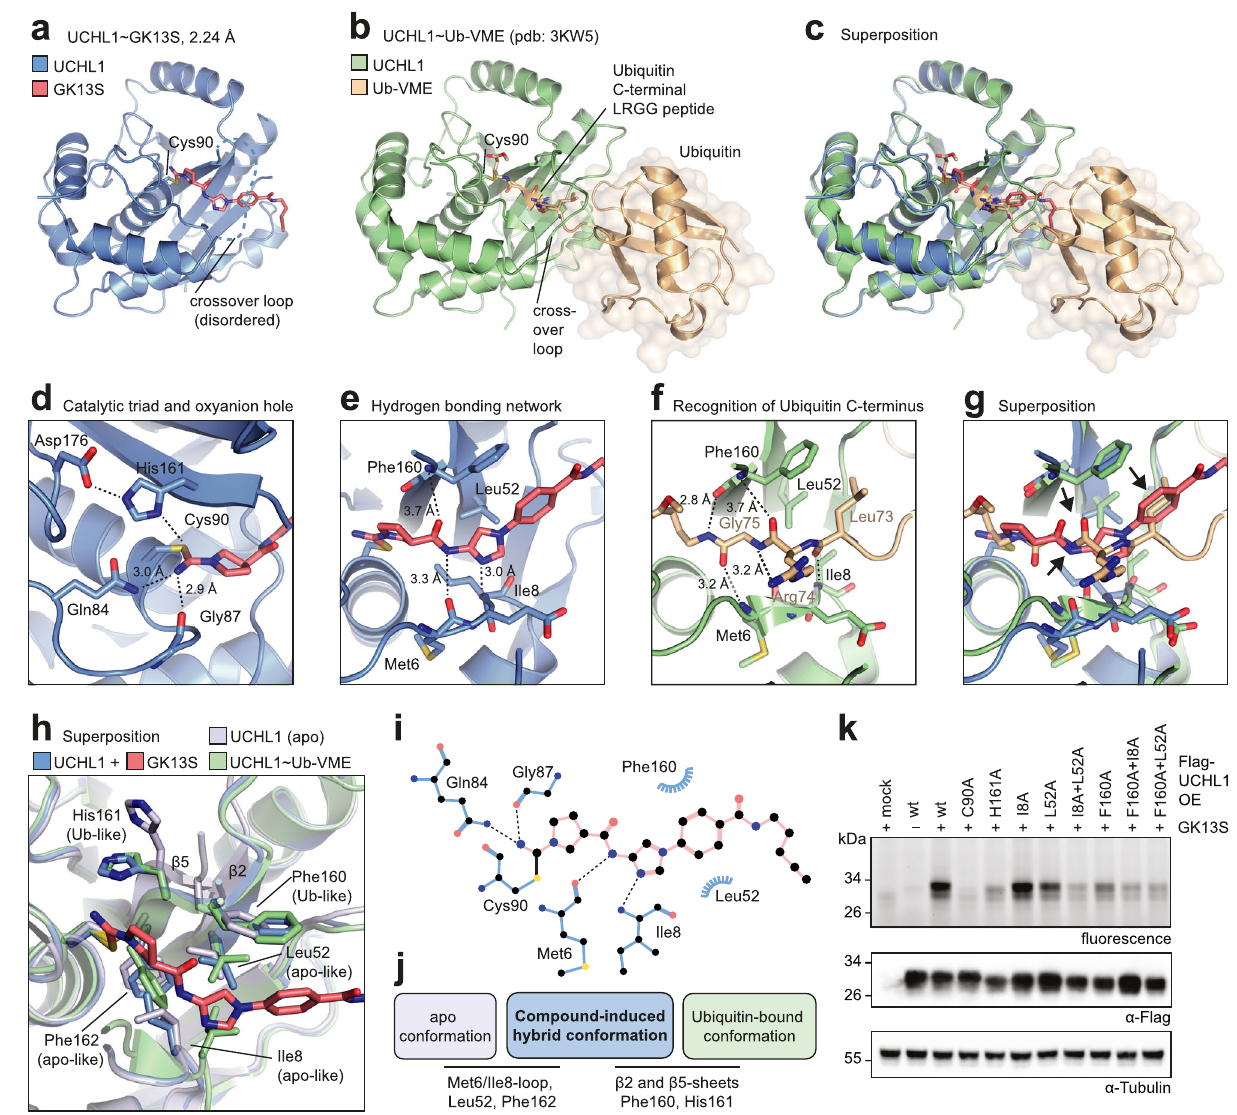
Fig. 5 | A compound-induced hybrid conformation underlies GK13S-mediated inhibitionofUCHL1.a StructureofUCHL1(blue)incomplexwithGK13S(red).The covalently bound active site cysteine 90 and the disordered crossover loop are indicated. b Structure of UCHL1 (green) in complex with Ub-VME (gold) (pdb: 3KW5).TheUbiquitinC-terminalresidues73 – 76arealsoshownassticks.VMEvinyl methylester. c Superpositionofaandb,highlightingthatthecompoundbindsinto the cleft, which is guiding the Ubiquitin C-terminus to the active site. d Close-up view on a, highlighting the oxyanion hole (Gln84 and Gly87) bound by the iso- thiourea nitrogen and the aligned catalytic triad residues Cys90, His161, and Asp176. Hydrogen bonds are shown as dotted lines, and their length is given. e Close-up view on a, highlighting residues of UCHL1 interacting with GK13S. f Close-upviewon b ,highlightingkeyinteractionsoftheUbiquitinC-terminuswith thebindingcleftofUCHL1. g Superpositionofeandf.Ubiquitinresiduesmimicked